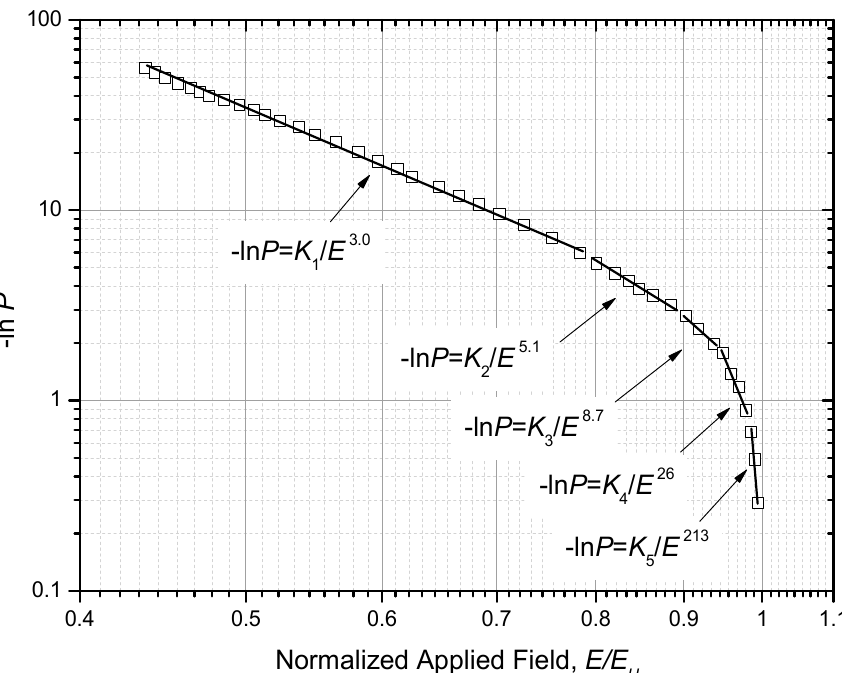
Figure 11. Plot of the e ff ect of − ln P on E / E H in a log-log coordinate system.